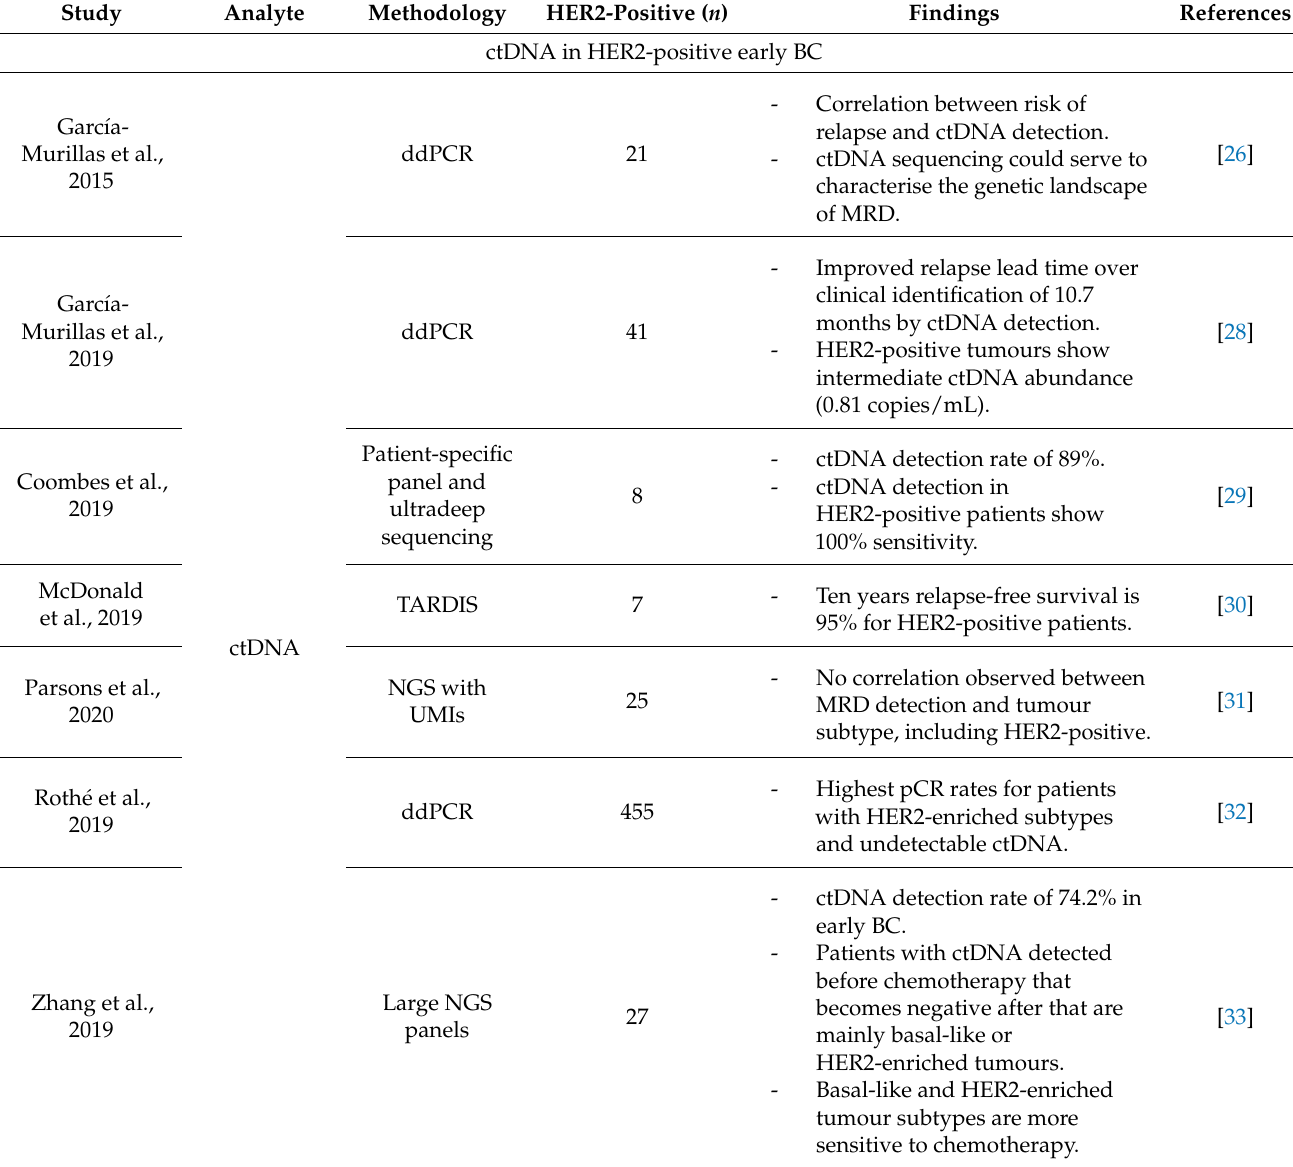
Table 1. Reviewed liquid biopsy studies in early and metastatic breast